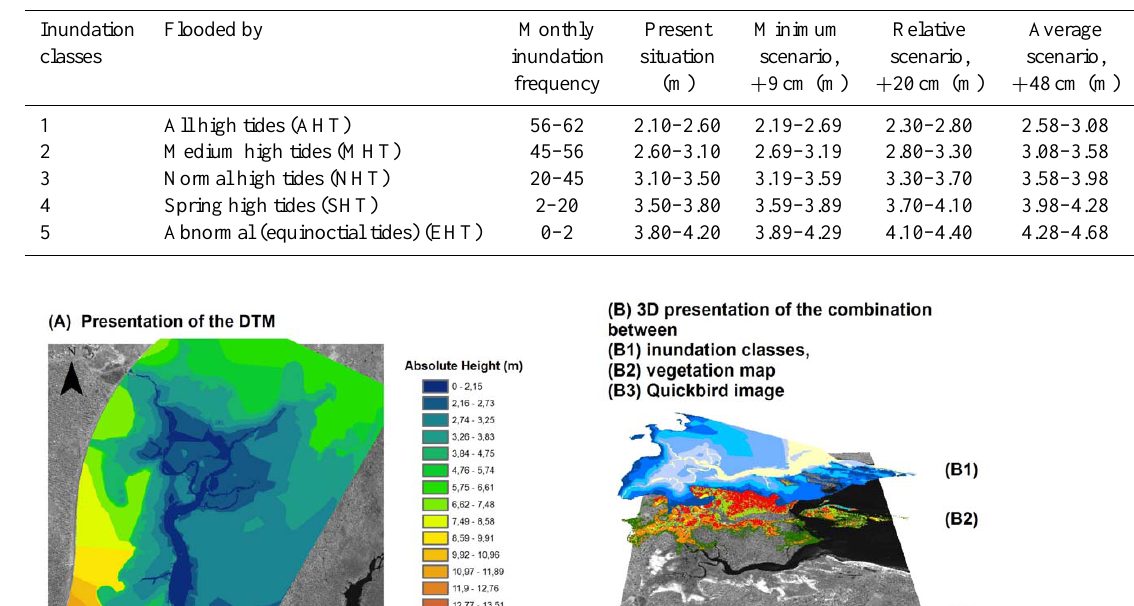
Table 1. Inundation classes and monthly inundation frequency according to Watson (1928). Height boundaries (metres above datum) of present and future inundation classes are presented: a minimum ( + 9cm), relative ( + 20cm), average ( + 48cm) and maximum ( + 88cm) scenario is based on IPCC eustatic SLR scenarios for the year 2100. In further analysis, inundation frequencies higher than those of “class